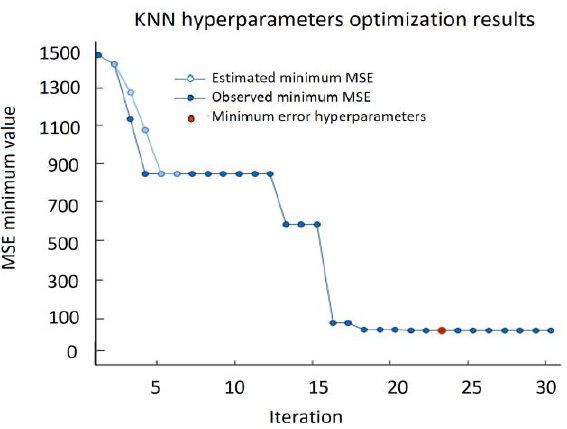
Figure 17. Minimum MSE during KNN hypermeters’ optimization process.